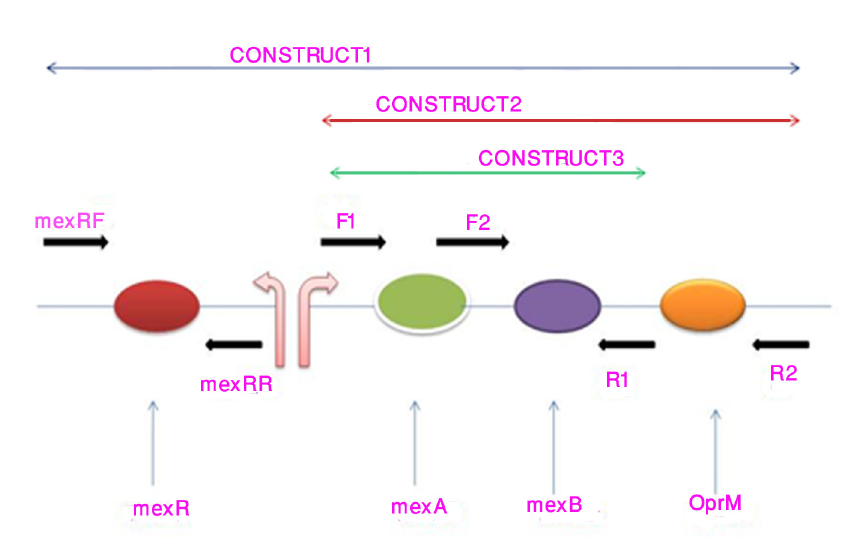
Fig 1. Figure describing different regions of mexAB-OprM operon which are amplified using different primers as shown.